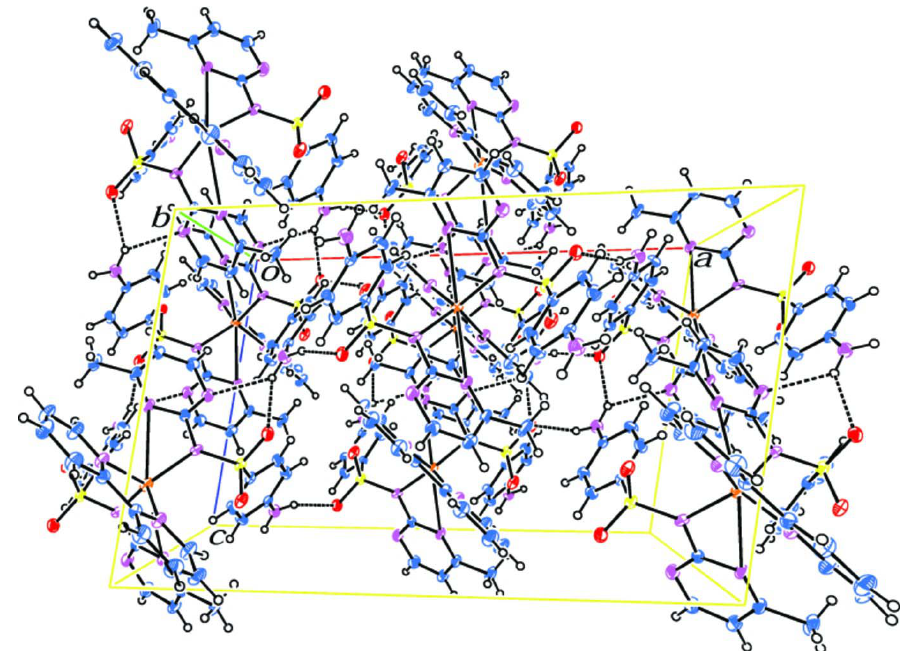
Figure 2 The packing of (I), viewed down the a -axis, showing one layer of molecules connected by N—H···N and N—H···O hydrogen bonds (dashed